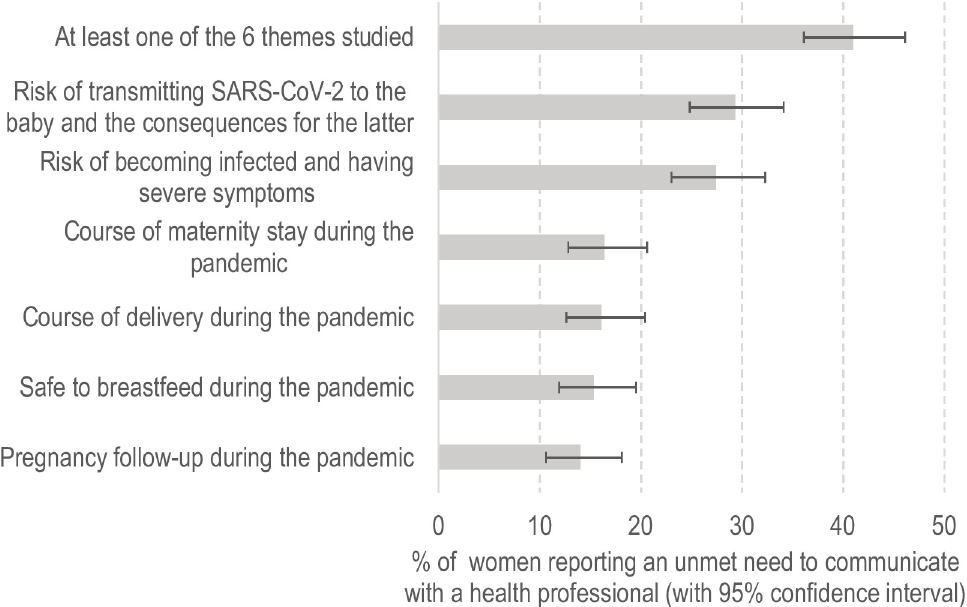
Fig 1. Pregnant women’s need to communicate with a health professional during the SARS-CoV-2 pandemic lockdown in